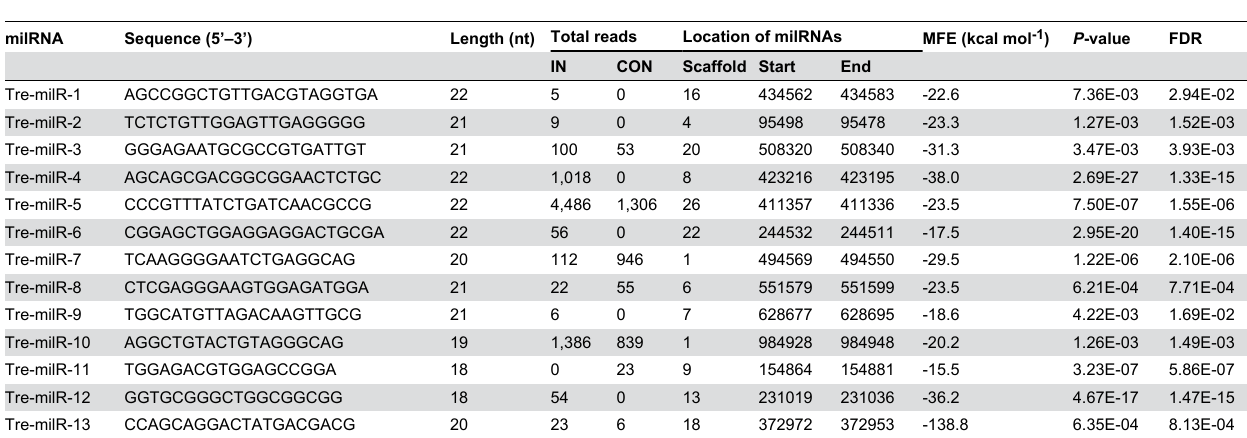
Table 2. T. reesei milRNAs identified by Solexa